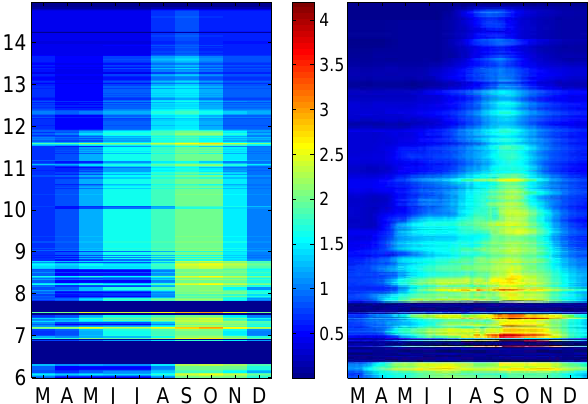
Fig. 10. LAI evolution (March to December 2007) along the north– south transect in West Africa from 15 ◦ N to 6 ◦ N: ECOCLIMAP-I (left) and LSA-SAF LAI (right)